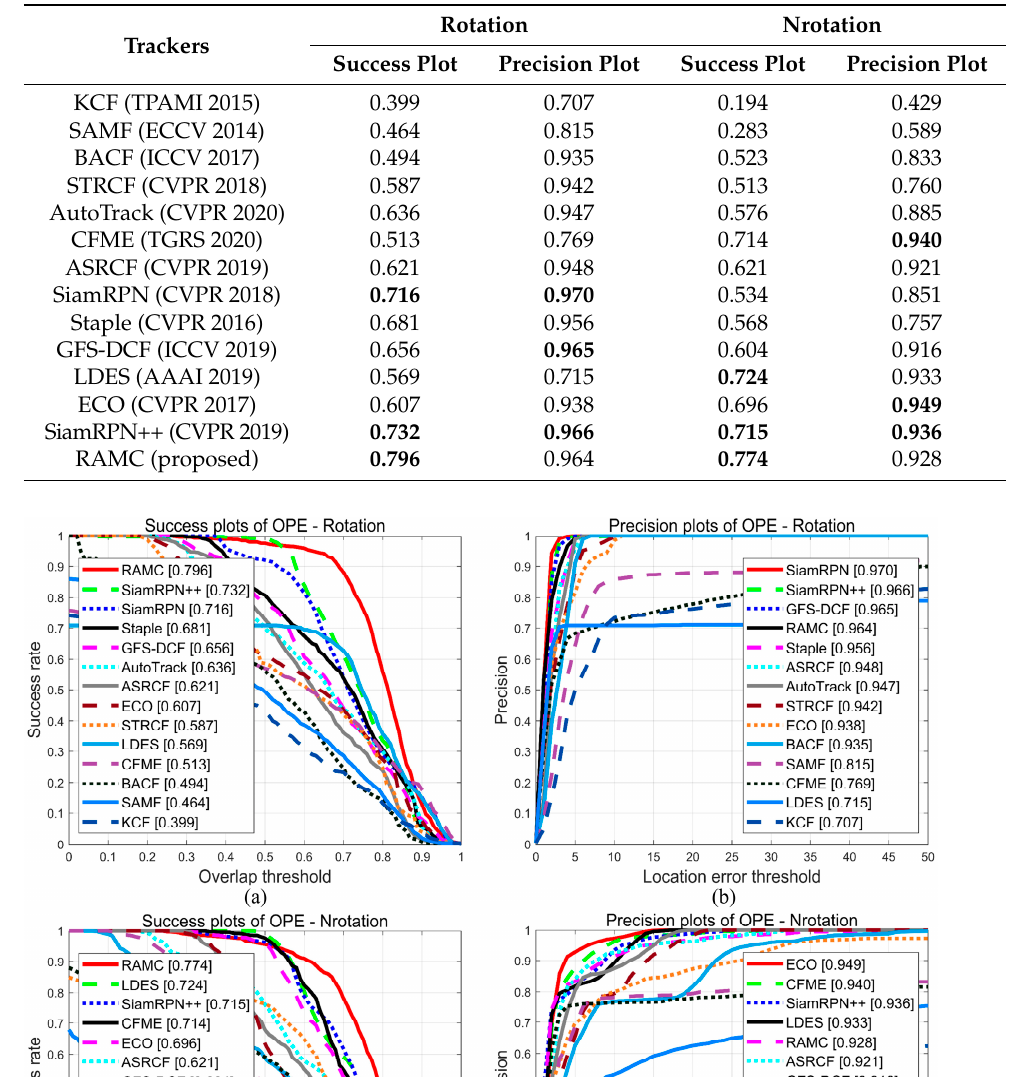
Table 5. The results of all algorithms on the Rotation and Nrotation datasets. The top three of each metric is bolded.